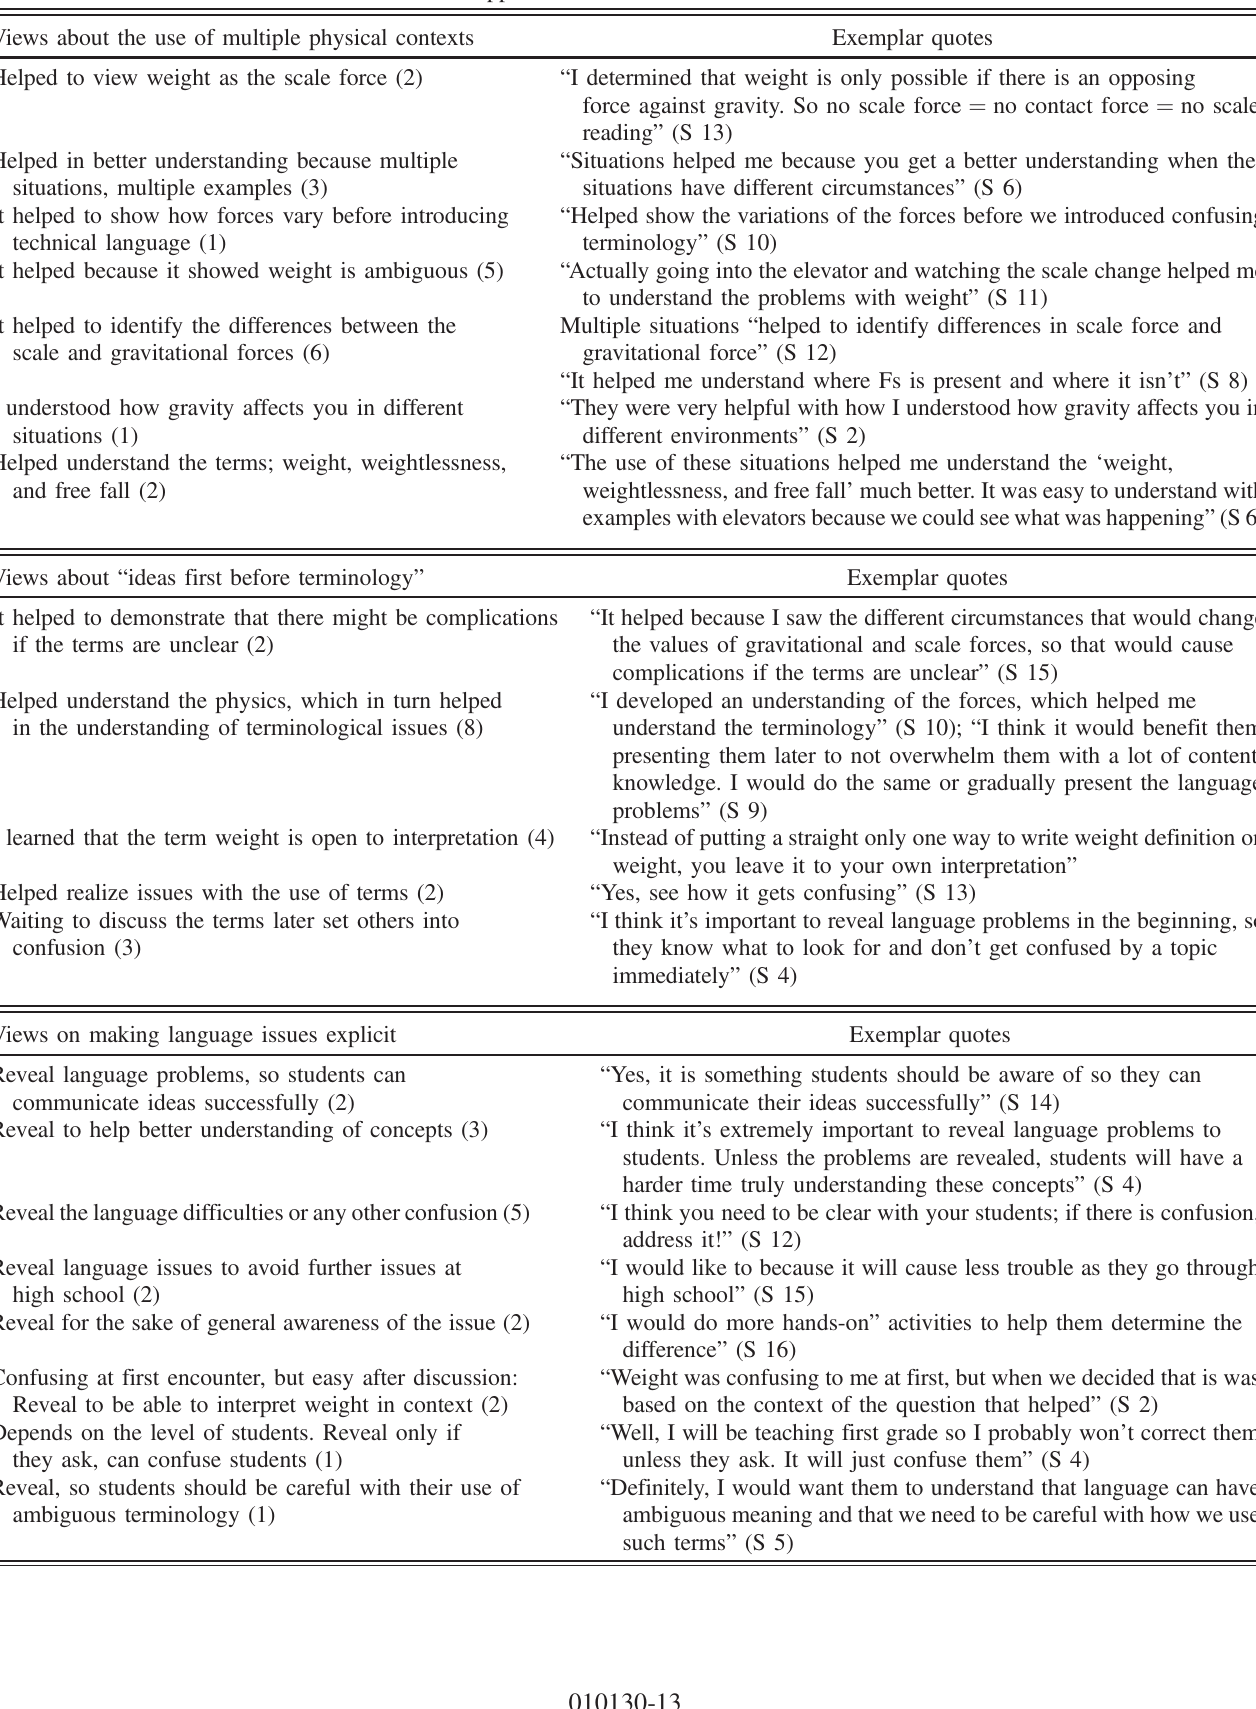
TABLE VI. Students ’ views of the instructional